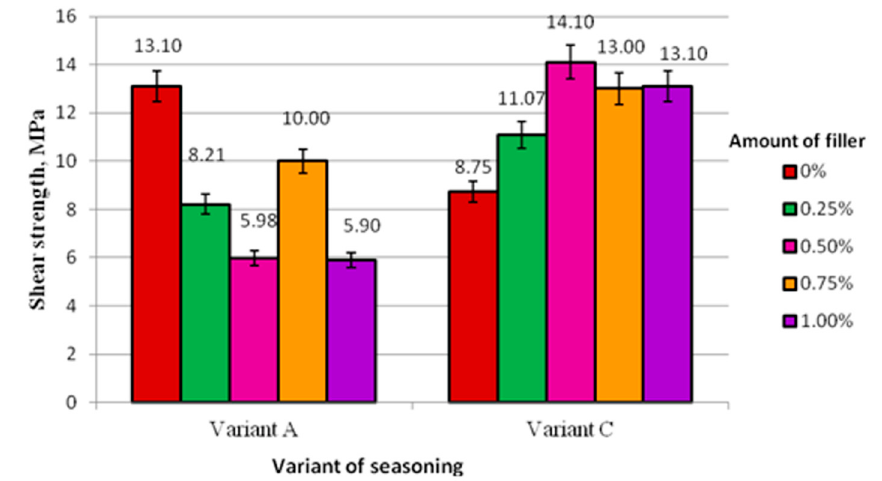
Figure 5. Tensile strength of adhesive joints produced according to Methods I and including Variant A and Variant C seasoning.